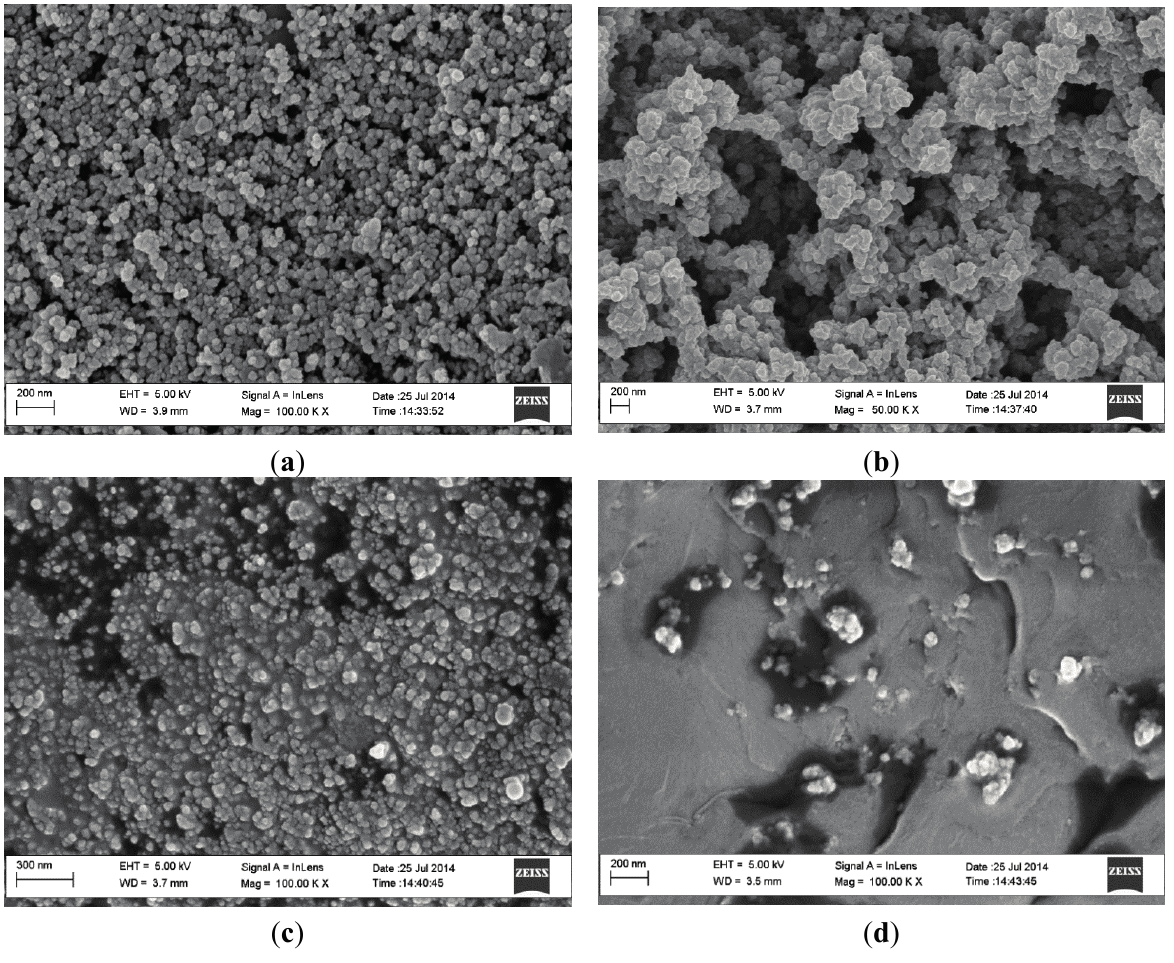
Figure 2. Scanning electron micrographs of ( a ) bare C-SPE; ( b ) PANI/PSSA//C-SPE; ( c ) Apt-NH 2 -glu-PANI/PSSA//C-SPE; and ( d ) TTX-Apt-NH 2 -glu-PANI/PSSA//C-SPE (where C-SPE is carbon screen printed